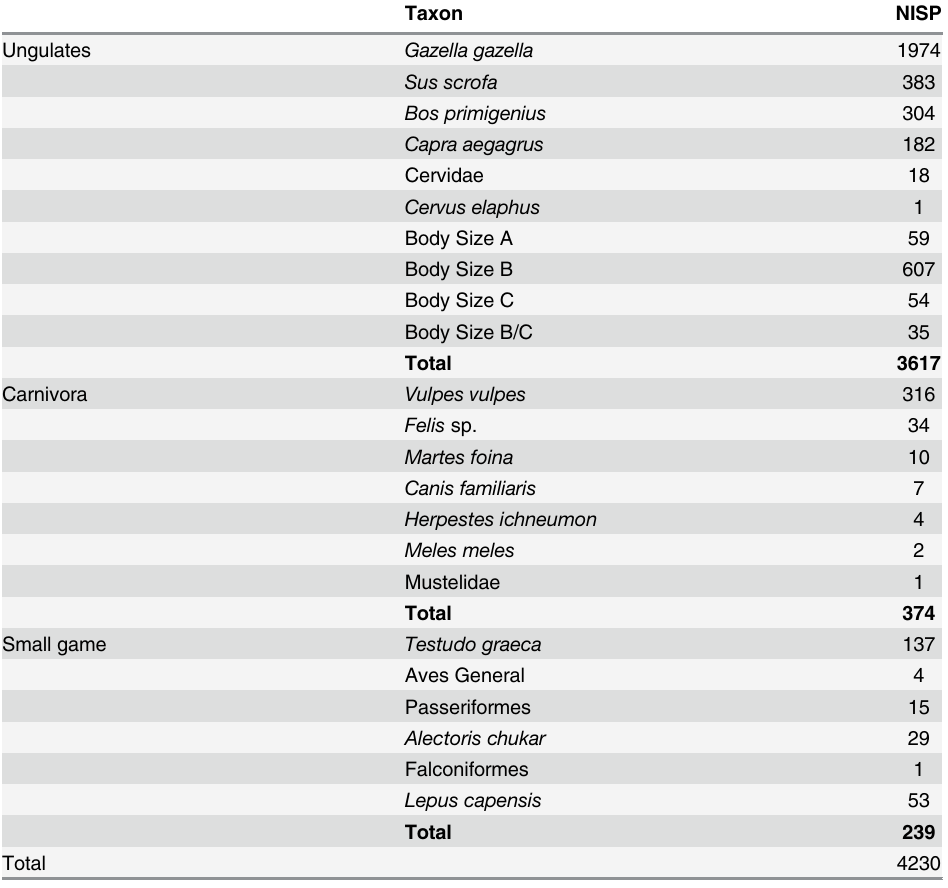
Table 1. Number of identified specimens (NISP) for all taxonomic groups identified at Yiftah'el. Taxon NISP Ungulates Gazella gazella 1974 Sus scrofa